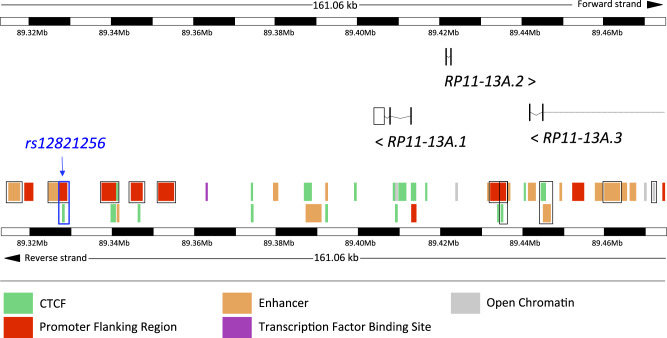
Genomic context of region in chromosome 12 affected by PAS. The image includes chromosome bands intercalated between black and white blocks with 10 kb of size, as well as several—sometimes overlapping—regulatory elements. The blue box encloses the regulatory region embracing a TFBS, a PFR, and a CTCF-BS that harbors rs12821256. Black boxes enclose enhancers, promoter-flanking regions, CTCF-BSs, and open chromatin regions associated by SNPs affected by PAS. Shown are the structures of RP11-13A1.1, RP11-13A1.2, and RP11-13A1.3, as well as the orientation of their coding sequences on the reference genome (“>” and “<” represent forward [5′–3′] and reverse [3′–5′] strands, respectively). Due to space limitations, we show the subregion with physical coordinates 12:89313336–89474394 instead of the whole region with coordinates 12:89193164–89556437. The image was adapted from an image retrieved from Ensembl.